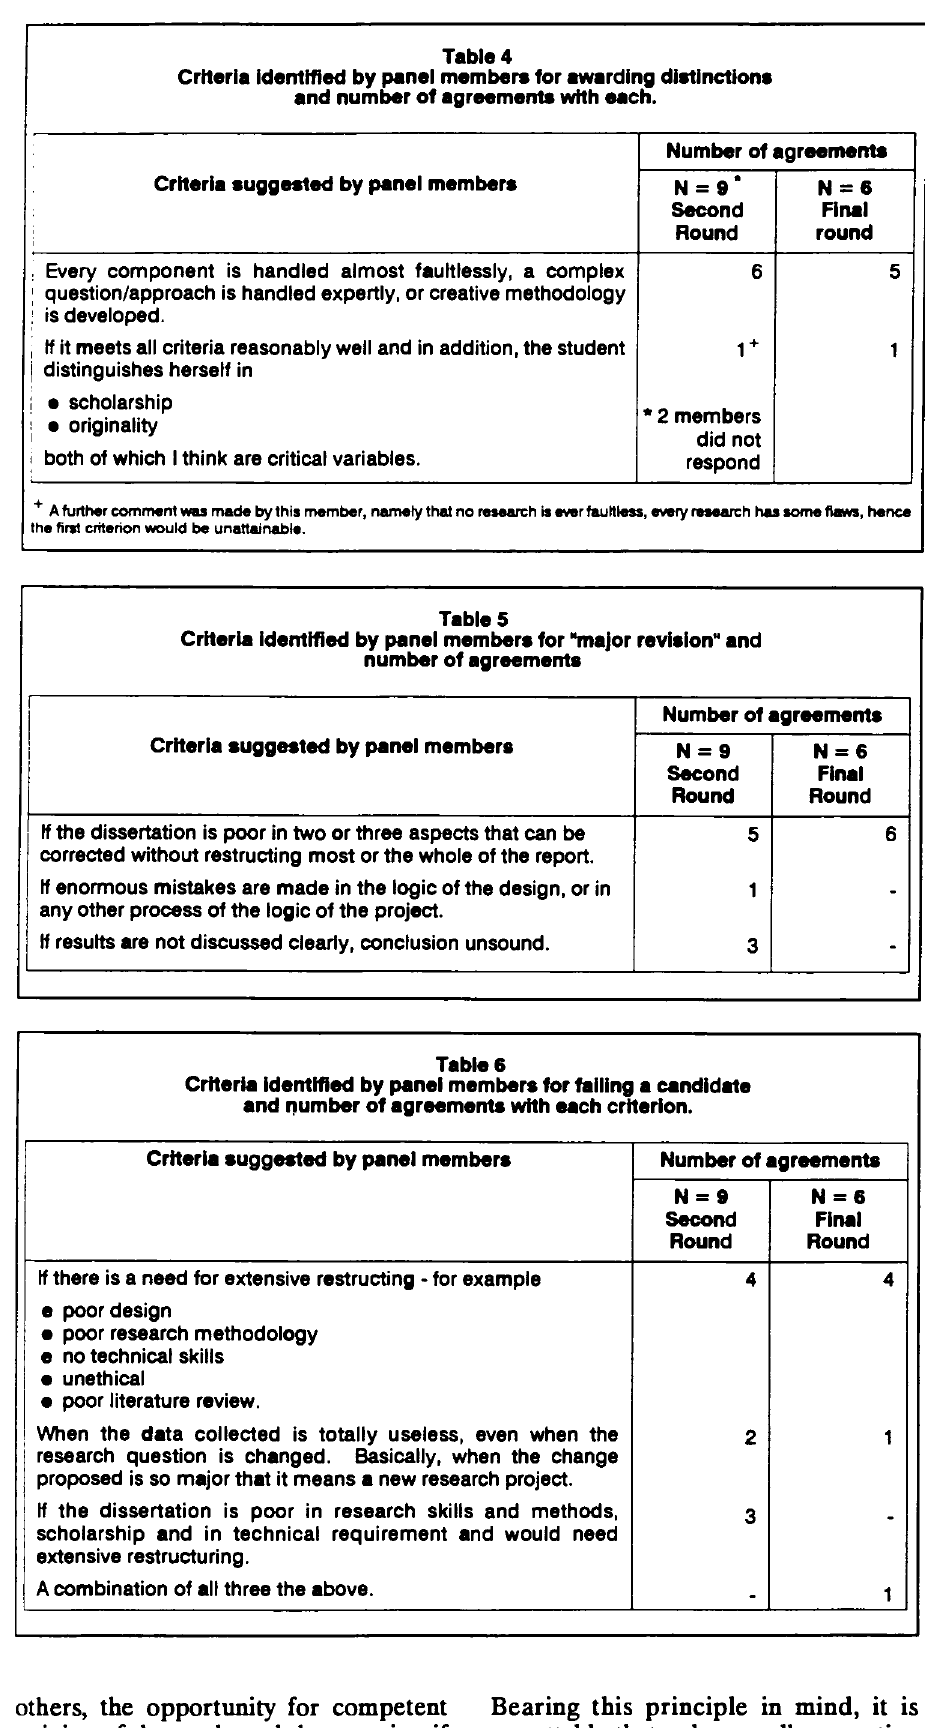
Table 4 Criteria Identified by panel members for awarding distinctions and number of agreements with each.